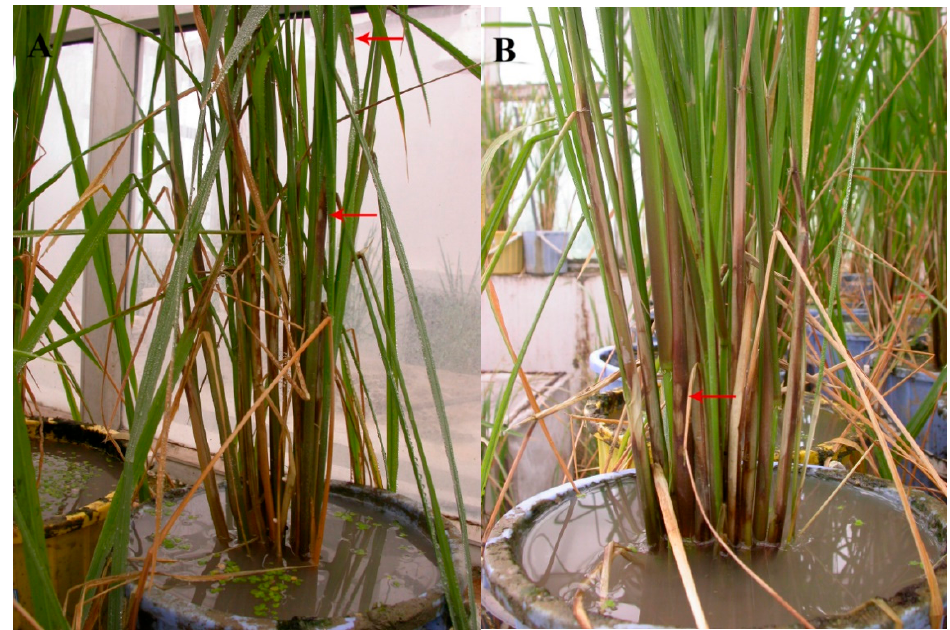
Figure 3. Lesions on rice leaves (shown by red arrows) caused by Rhizoctonia solani. ( A ) Infected control rice plant inoculated only with R. solani . Perceptible lesions are present also at higher parts of the plant, meaning a higher relative lesion length (RLH) and also implying a higher level of severity of the disease. ( B ) Rice plant inoculated with R. solani and T. harzianum AS12-2. Lesions occur at lower parts of the plant, which means a decreased